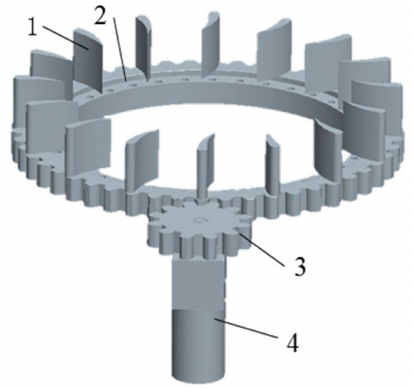
Figure 3. Sketch of the rotating wind deflector system. 1—Wind deflector; 2—Slewing bearing; 3—Driving gear; 4—Driving motor.